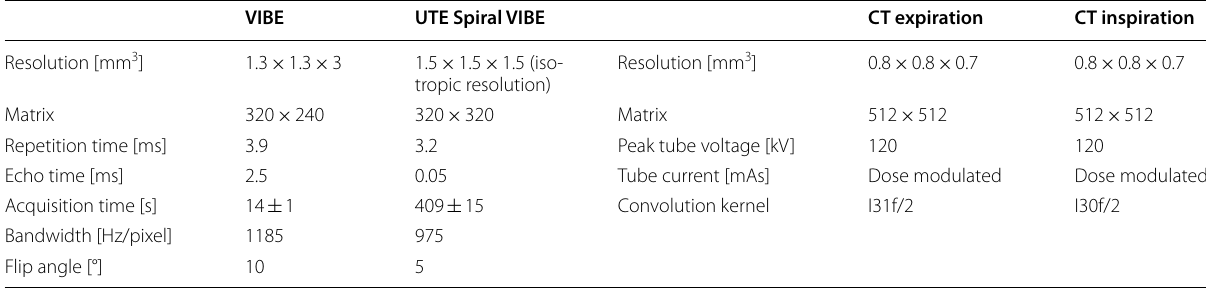
Table 1 Overview of the MR and CT data acquisition